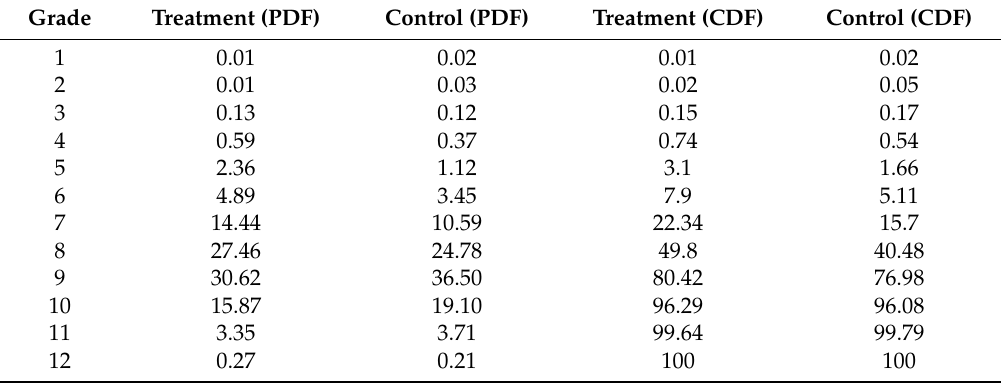
Table 9. Simulated school enrollment distribution at age 15 for treatment and